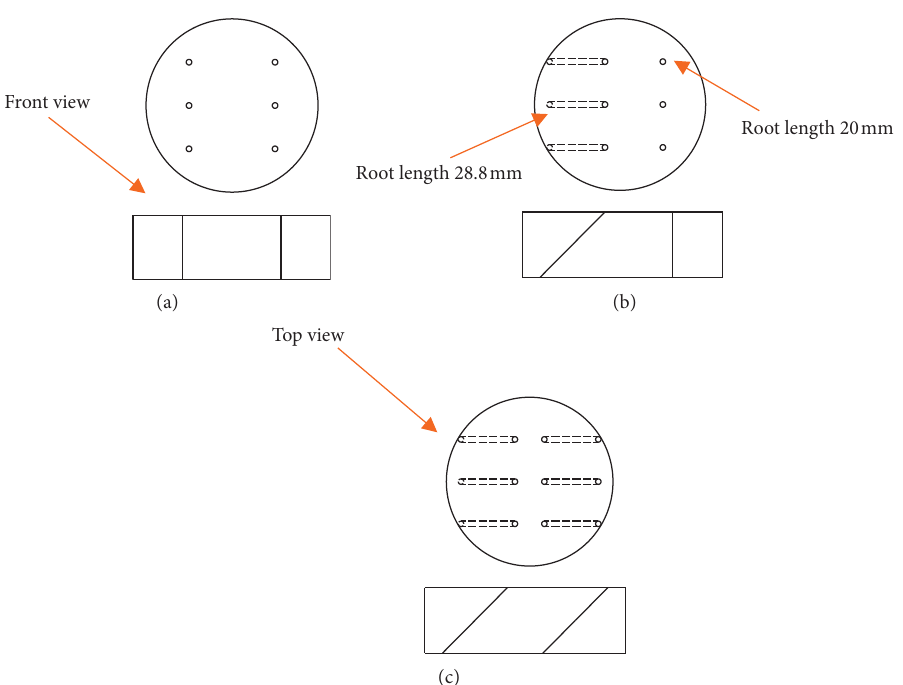
Figure 5: Top view and main view of three root insertion modes: (a) 90 ° +90 ° ; (b) 90 ° +45 ° ; (c) 45 ° +45 °